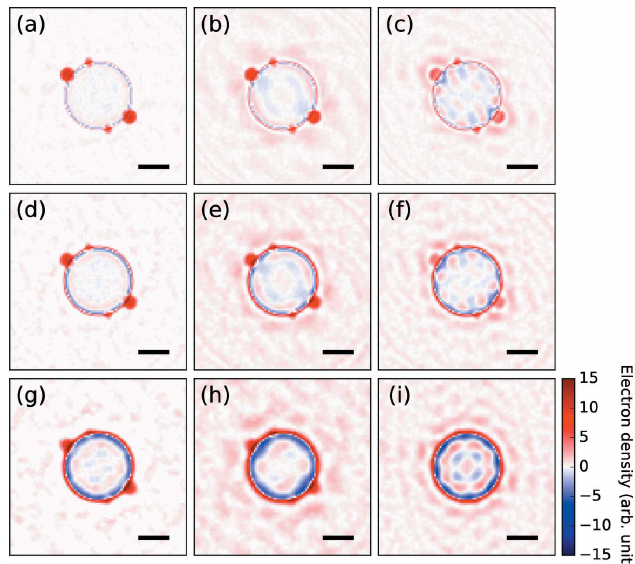
Figure 5 Electron density reconstructed from the simulation data. The initial electron density [Fig. 2( b )] was subtracted from the reconstructed results (Fig. 4). The scale bars are 100